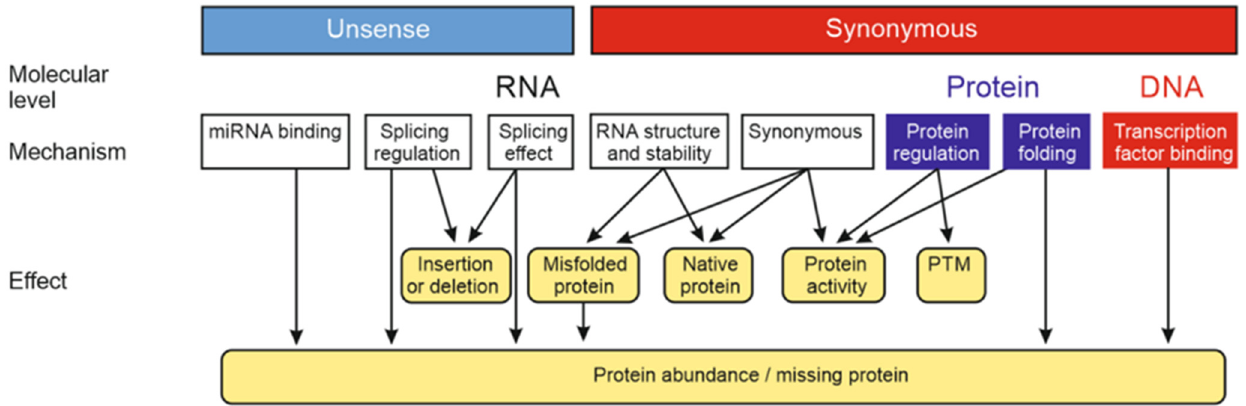
Figure 2. Novel classification of unsense and synonymous variations, molecular levels where they have functions, their mechanisms, as well as effects. Synonymous variants can affect DNA (red boxes), RNA (white) and protein levels (blue), whereas unsense variants are at RNA level and affect splicing, regulation or binding. PTM, post translational modification.